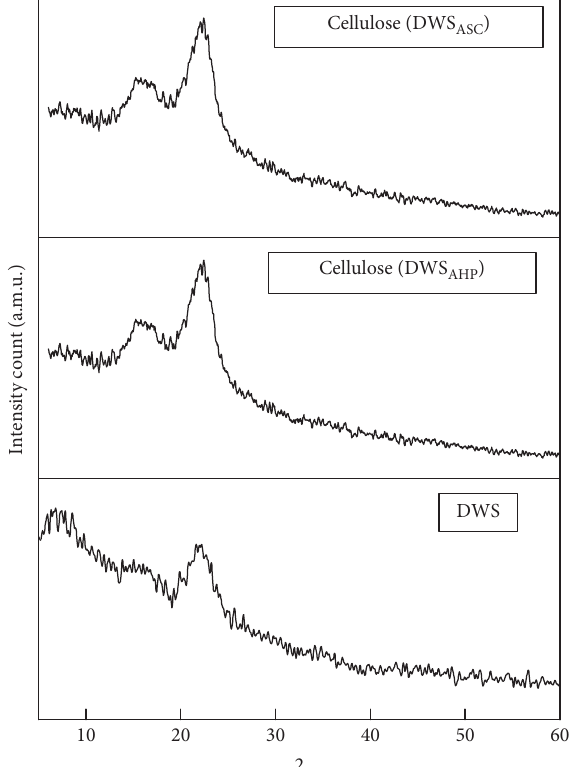
Figure 2: X-ray diffractogram of DWS, cellulose (DWS cellulose (DWS AHP ).